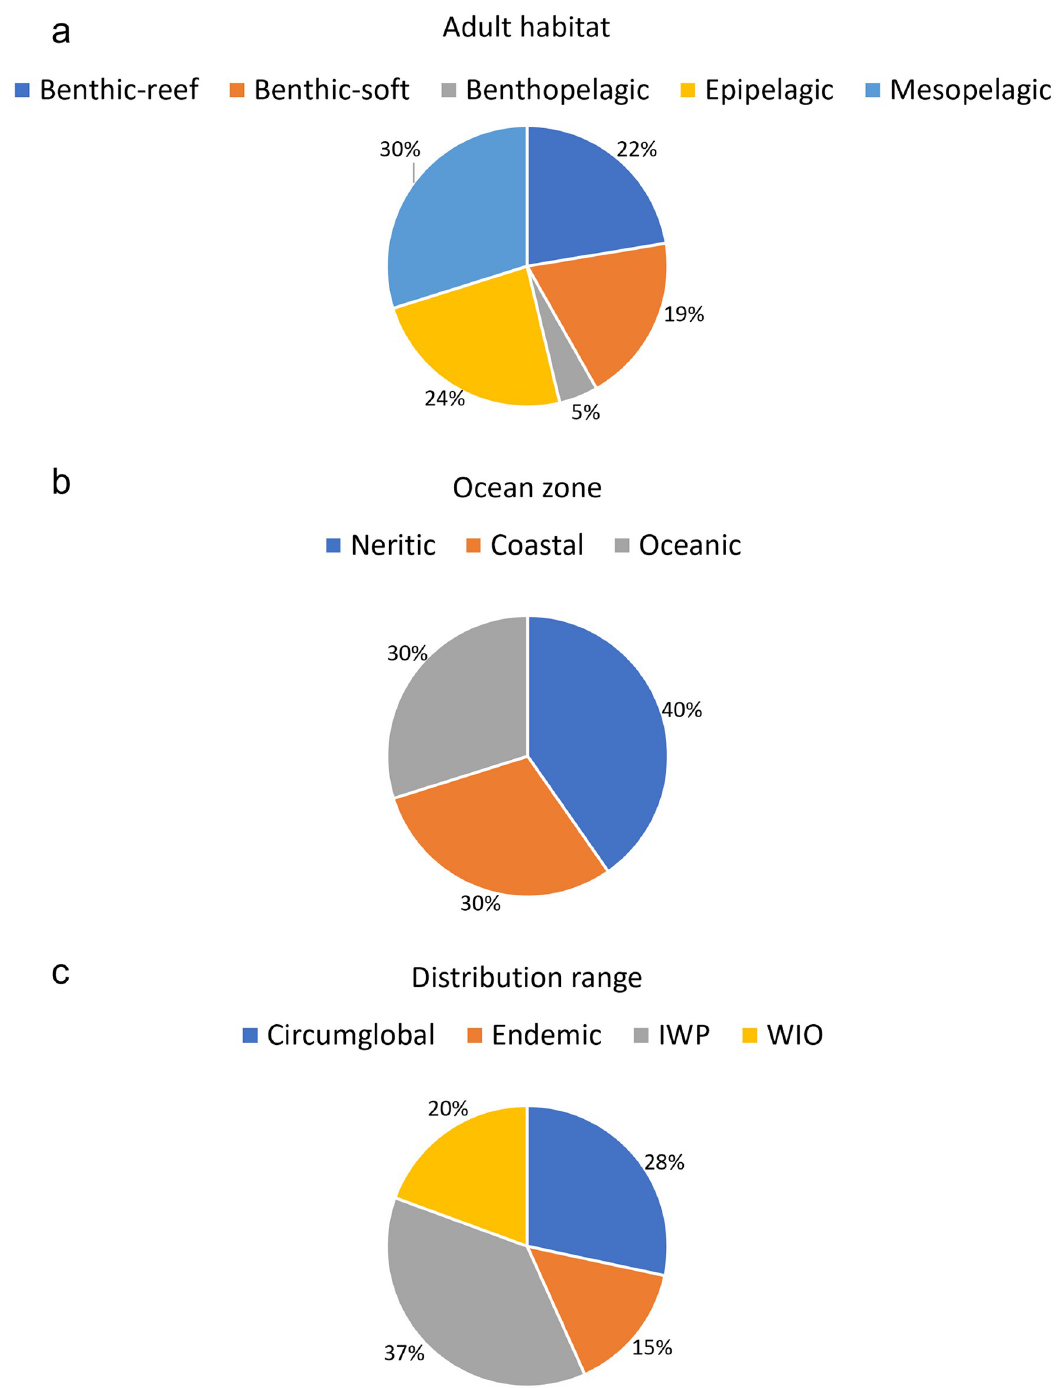
Fig 3. Proportional occurrence of ichthyoplankton species detected by metabarcoding of zooplankton, categorized according to existing data of (a) adult habitats, (b) ocean zone and (c) geographical distribution ranges (WoRMS; GBIF; OBIS).